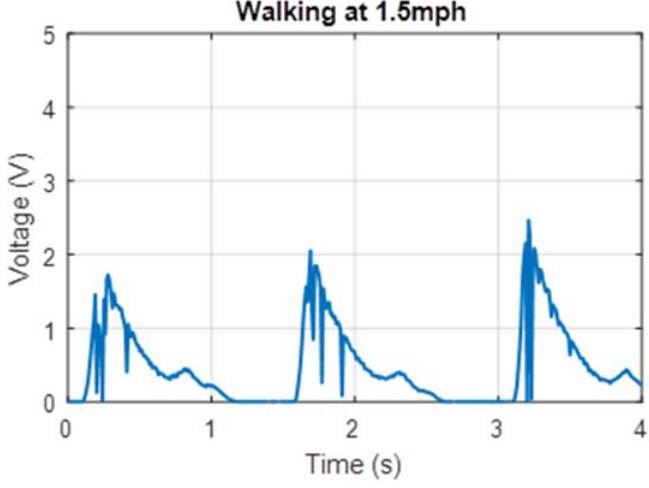
Figure 6. Voltage output measured for 0.5 Hz footsteps.